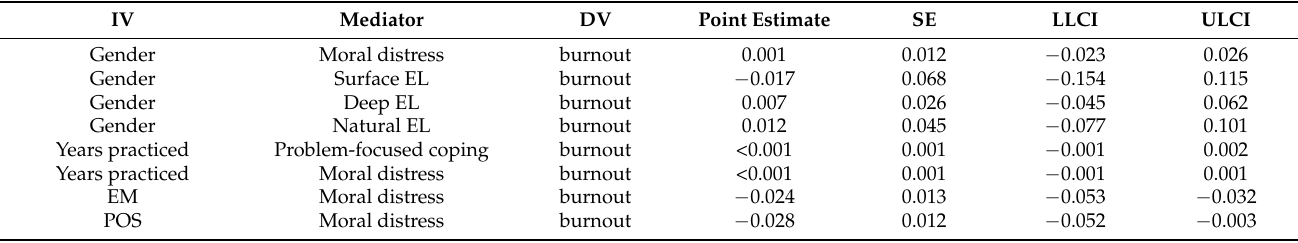
Table 4. Impact of moral distress, emotional labor (EL), and coping on physician